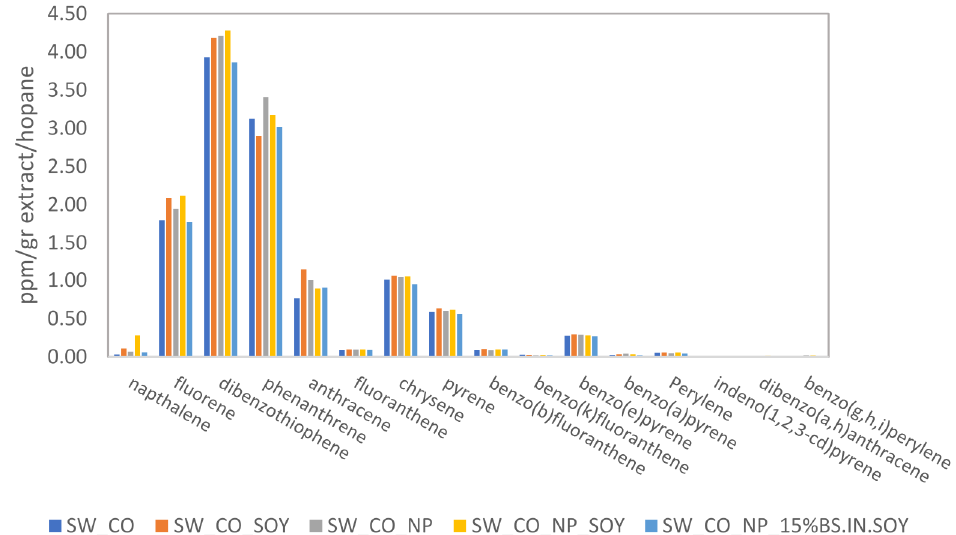
Figure A6. Bioremediation test results. Aromatic hydrocarbons concentration after 7 days of bio-